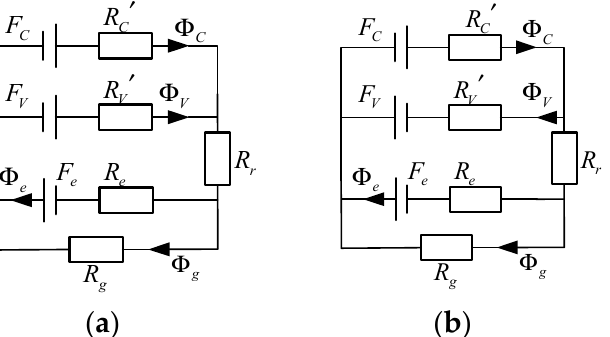
Figure 6. Equivalent magnetic circuit with excitation magnetomotive force. ( a ) Forward parallel equivalent magnetic circuit; ( b ) reverse parallel equivalent magnetic circuit.